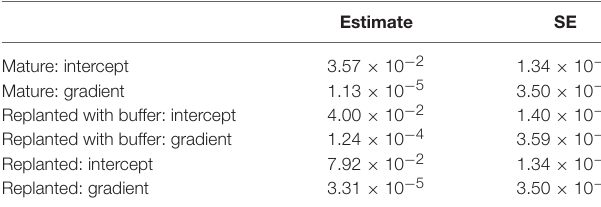
TABLE 4 | Model coefficients for the best herbivory model: Transformed_Herbivory ∼ Vegetation Type * Distance + (1|Site). Mature: